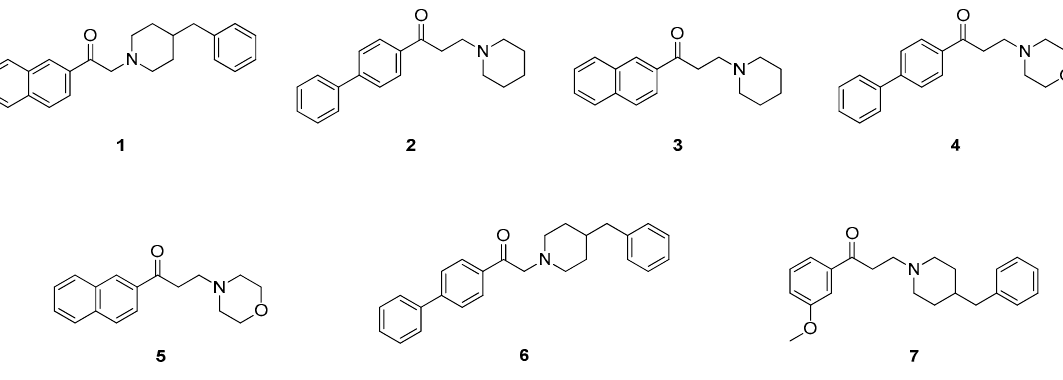
Figure 3. Chemical structures of the previously developed S1R ligands, which have been assessed in the present work for docking calculation.